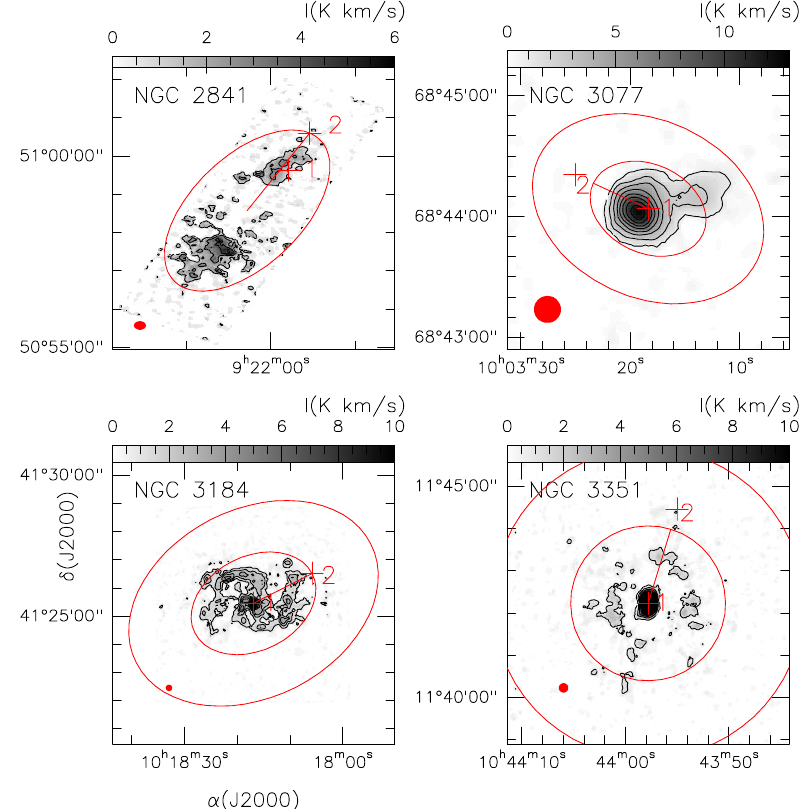
Figure 1. CO(2-1) integrated intensity maps of our galaxy sample. The red crosses show positions used to extract the spectra shown in Figure 2. The red ellipses indicate the regions used to measure CO(2-1) luminosities (see text). The tiny filled red ellipse represents the IRAM telescope beam (13 arcsec at the CO(2-1) frequency transition of 230.538 GHz). For NGC 2841, we did not measure the CO(2-1) luminosity in the galaxy outskirts, as in this particular case was not